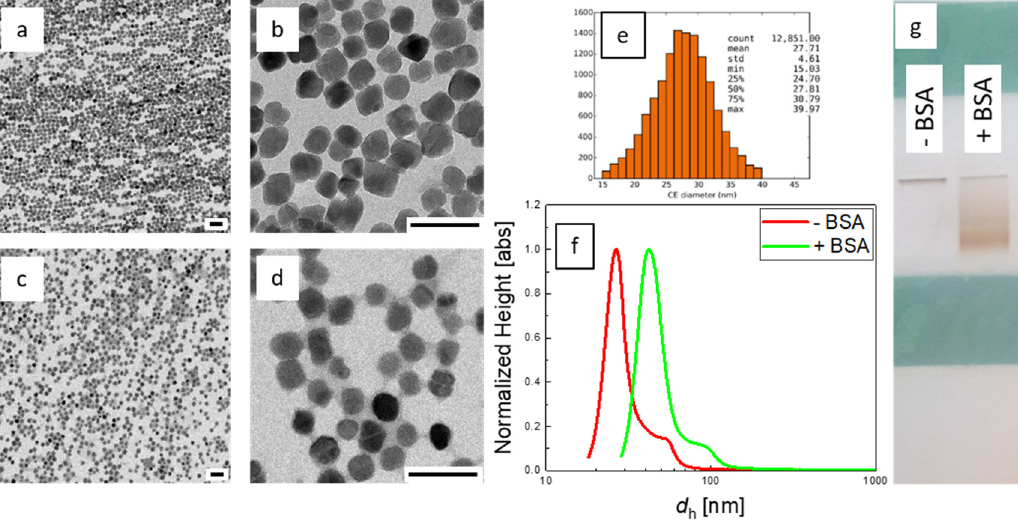
Figure 2. Physicochemical characterization of continuously synthesized MNP. TEM images (scale bar 100 nm) of centrifuged MNP without BSA-coating ( a , b ) and with BSA-coating ( c , d ). Core diameter histogram from TEM image analysis of uncoated MNP ( e ). Hydrodynamic size distribution obtained by DCS ( f ) of centrifuged MNP without BSA (red line), and with BSA-coating (green line). Agarose gel electrophoresis ( g ) shows a high mobility of BSA-coated MNP (+BSA, right ) and nearly immobilized MNP without BSA-coating ( − BSA, left ).